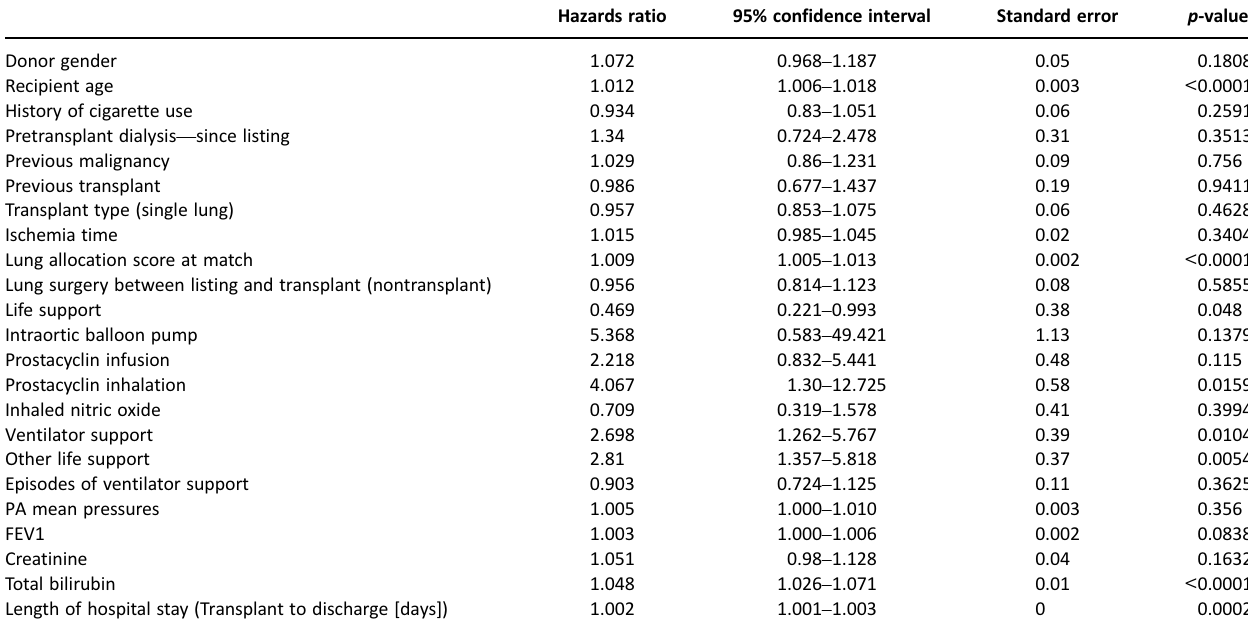
Table 3. Multivariate analysis.